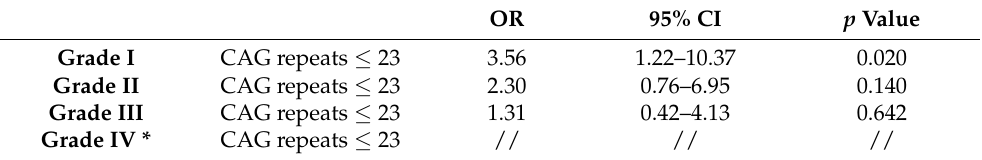
Figure 4. Percentages of subjects with ≤ 23 or >23 CAG repeats, according to disease severity (4 grades). Table 2. Results of logistic regression between COVID-19 severity (dependent variable) and the number of CAG repeats (independent variable). * Grade IV is considered as a reference. Key: OR: Odds Ratio, CI = confidence interval.